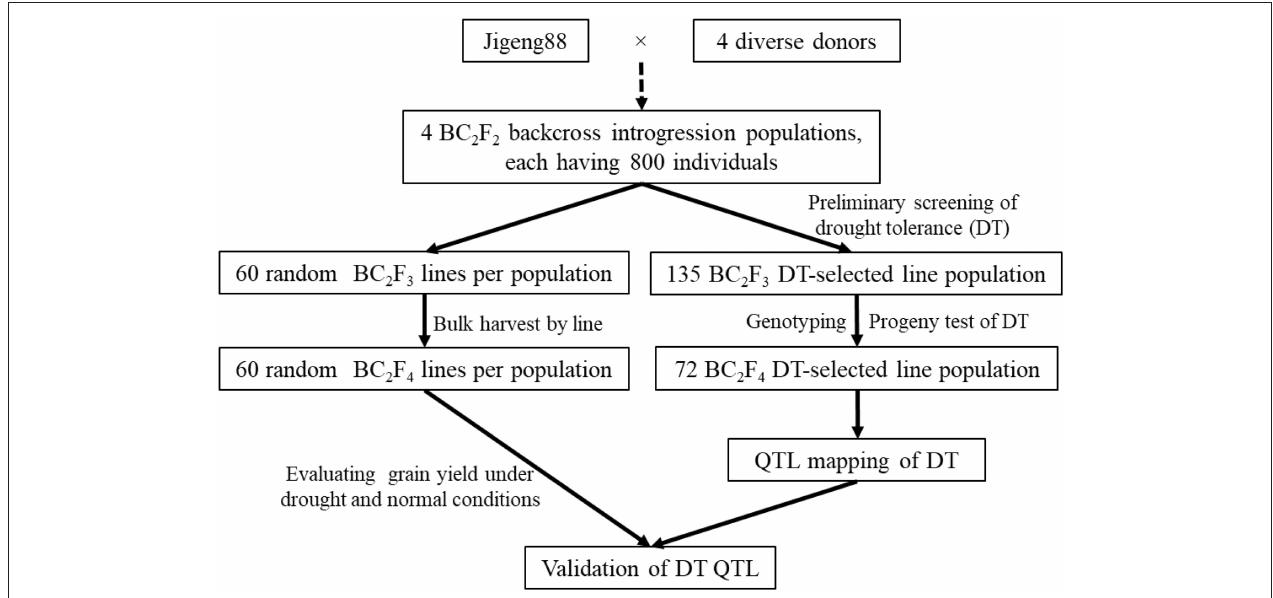
FIGURE 2 | Flowchart of the population development for identification and validation of QTL for drought tolerance in rice.